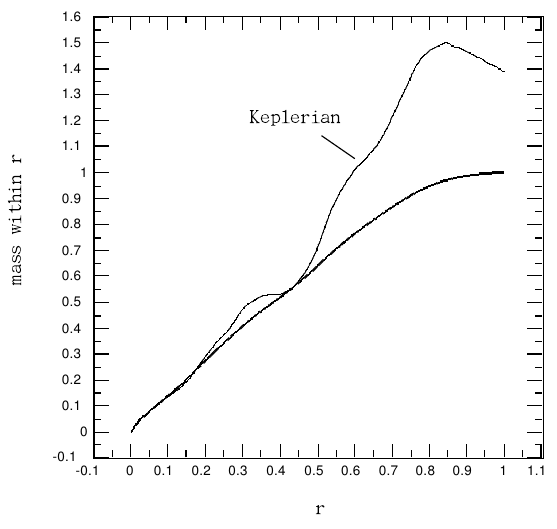
Figure 9. Profiles of the Milky Way mass within radial distance r (thick line), (cid:82) r ρ (ˆ r ) ˆ rd ˆ r , and that estimated with Keplerian dynamics (thin line as labeled), M ( r ) = 2 π h 0 M ( r ) = A r V ( r ) 2 . K